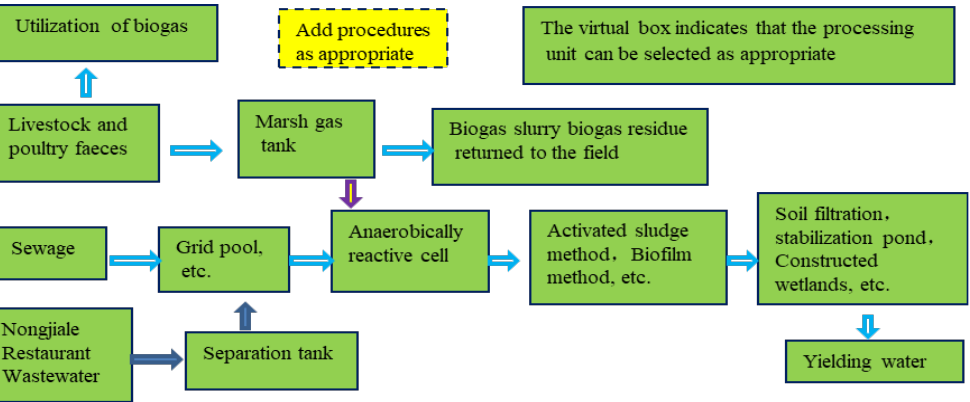
Figure 6. Biogas digester, anaerobic biological treatment, aerobic biological treatment and constructed wetland.